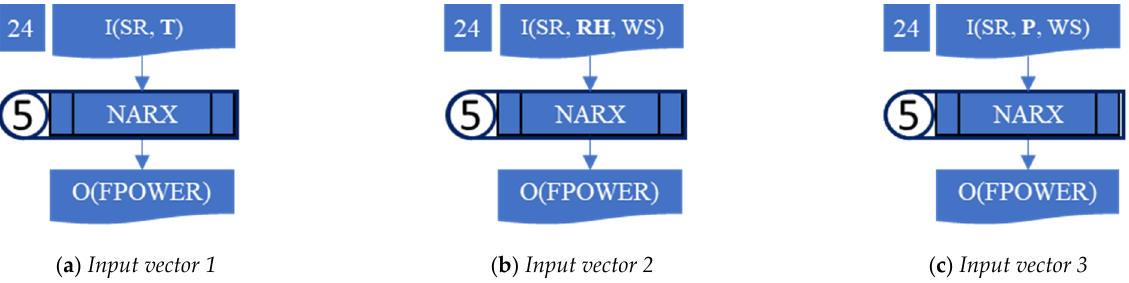
Figure 9. Development of the NARX models using different input vectors for electrical power prediction (FPOWER).